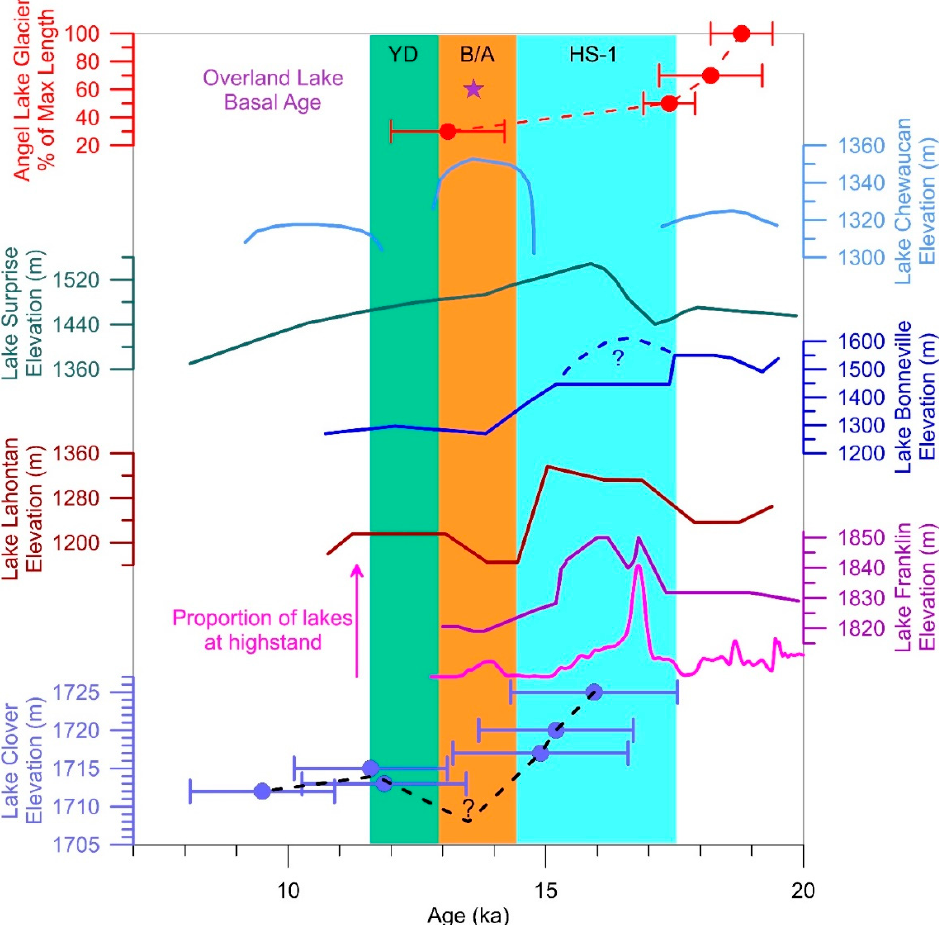
Figure 14. Comparison of the hydrograph for Lake Clover (dashed black line) with other pluvial lake hydrographs for the Great Basin including Lake Franklin [13], Lake Lahonton [32], Lake Bonneville [6], Lake Surprise [31], and Lake Chewaucan [9]. A summary of lake highstands, including Lake Clover, is shown in pink [14]. Dated moraines at the Angel Lake type locality (red recalculated from [33]), and the calibrated basal 14 C age for Overland Lake (star [16]) are also shown for reference. The regression of Lake Clover late in Heinrich Stadial 1 also matches falling water levels in the other well-dated lakes and a major decrease in the number of lakes at their highstand levels in the regional compilation (Figure 14). The elevation of Lake Clover during the Bølling / Allerød